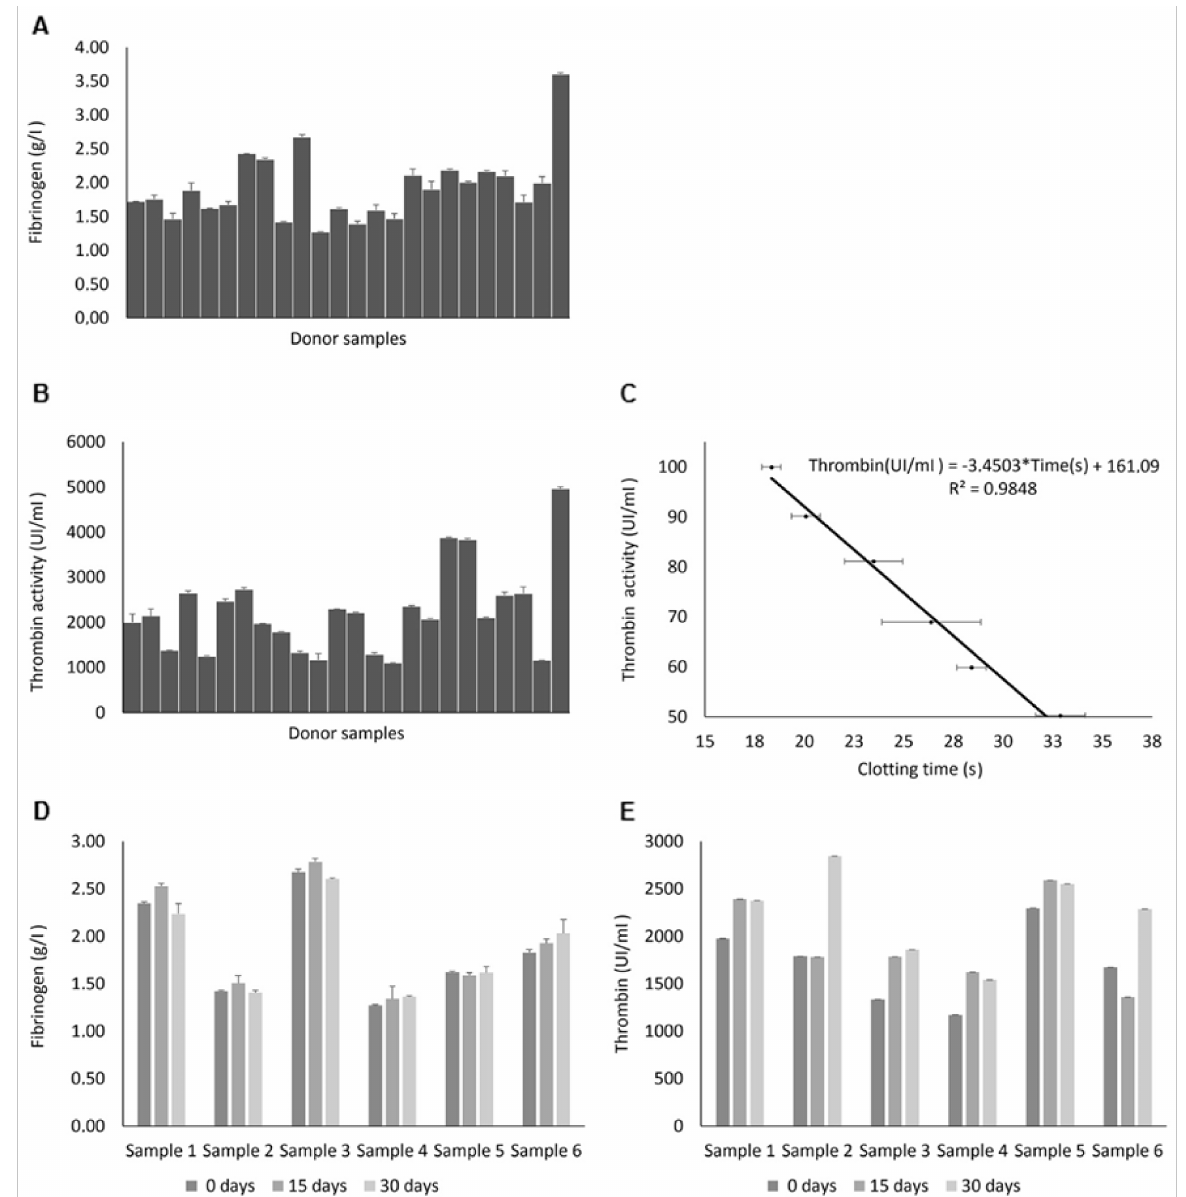
Figure 1. Analysis of thrombin concentrate and fibrinogen samples. ( A ) Fibrinogen concentra- tion (g/L) in each FFP used. ( B ) Enzymatic activity (UI/mL) in each thrombin concentrate pro- duced. ( C ) Standard curve used to calculate the enzymatic activity of each thrombin concentrate [y (UI/mL) = − 3.4503 × x(s) + 161.09]. ( D ) Fibrinogen concentration (g/L) variation after storage at − 80 ◦ C and thawing at different times up to 30 days. Samples did not show a significative depletion ( p > 0.05). ( E ) Enzymatic activity (UI/mL) variation after storage at − 80 ◦ C and thawing at different times up to 30 days. Samples did not show a significative depletion ( p > 0.05). Data expressed as mean ±